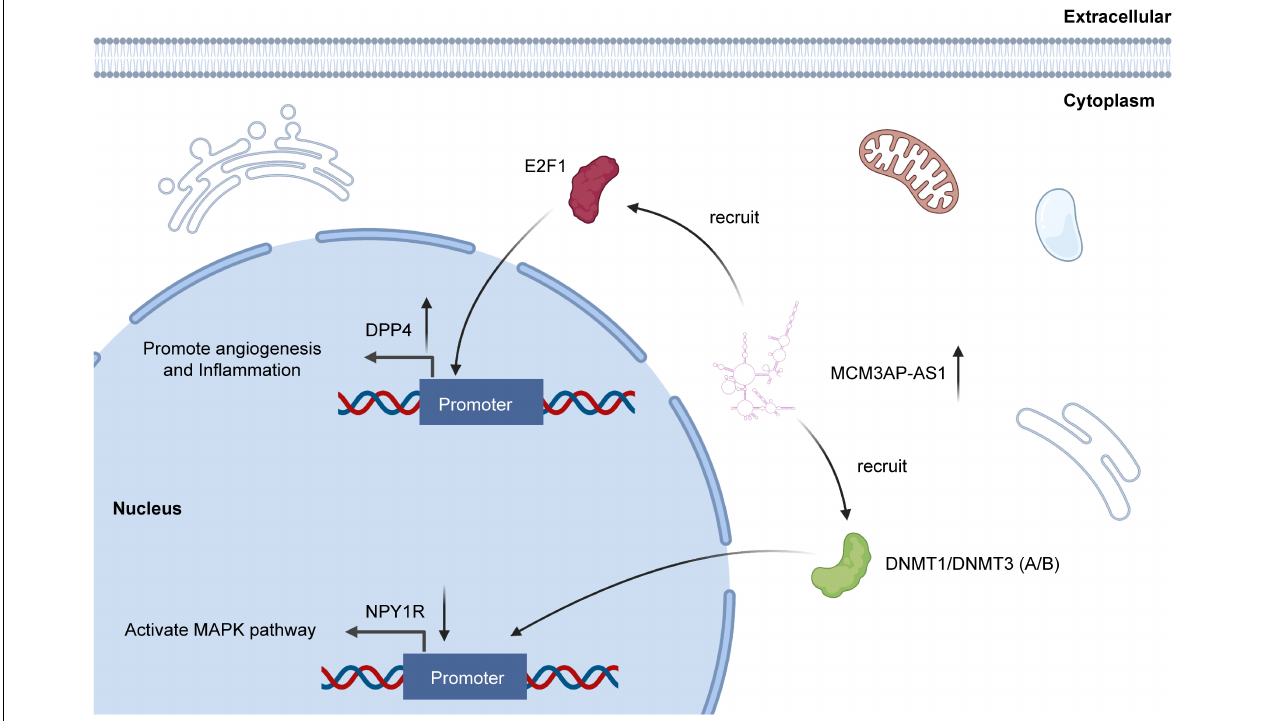
FIGURE 4 | MCM3AP-AS1 functions through directly interacting with proteins. MCM3AP-AS1 enhances methylation of NPY1R promoter through recruitment of DNMT1/DNMT3 (A/B), thereby downregulating NPY1R to activate the MAPK pathway. MCM3AP-AS1 is also shown to promote the E2F1 enrichment at the DPP4 promoter, increasing DPP4